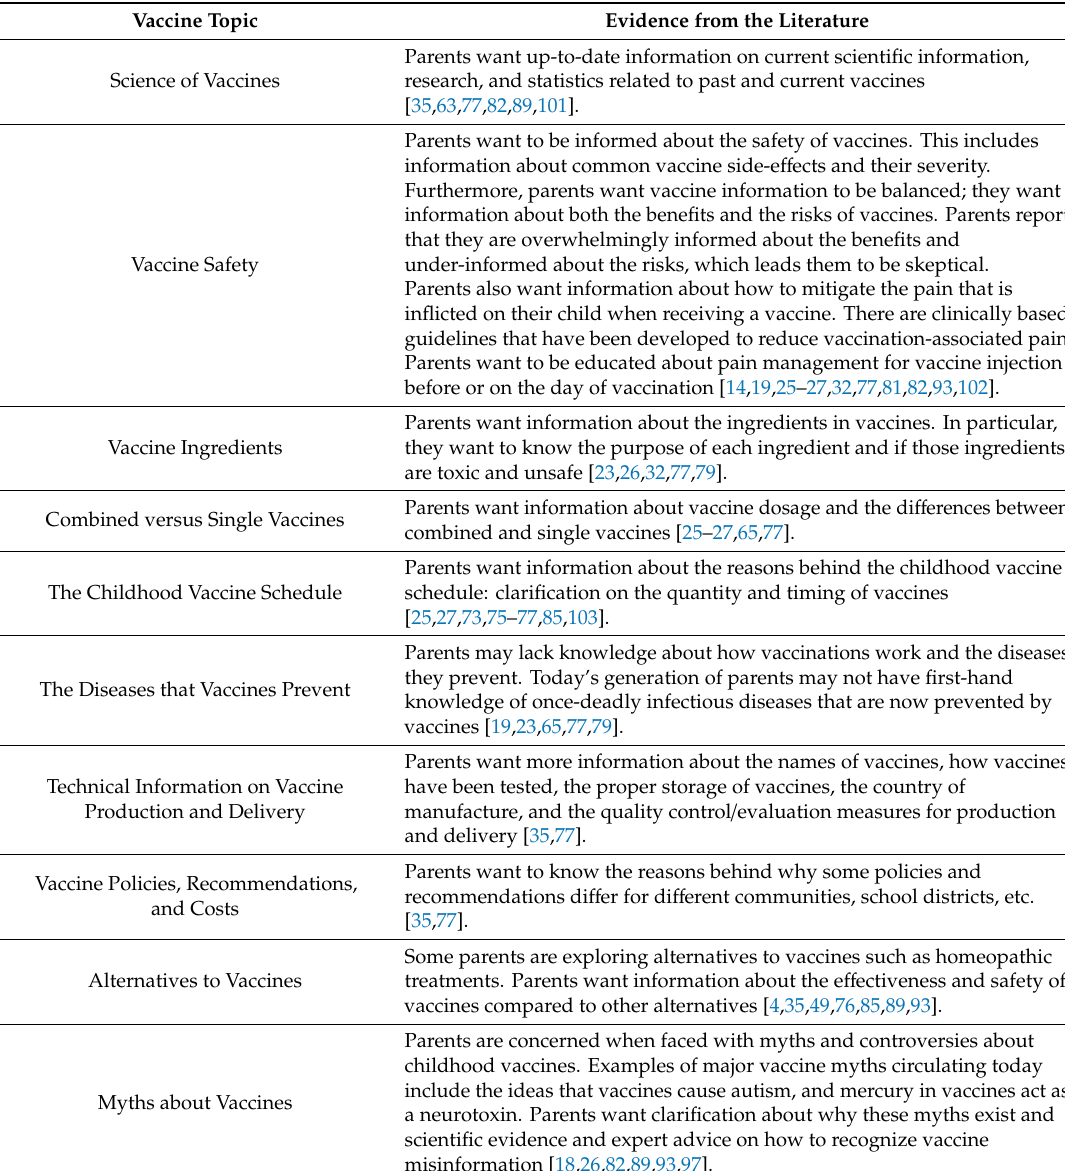
Table 6. Content of vaccination